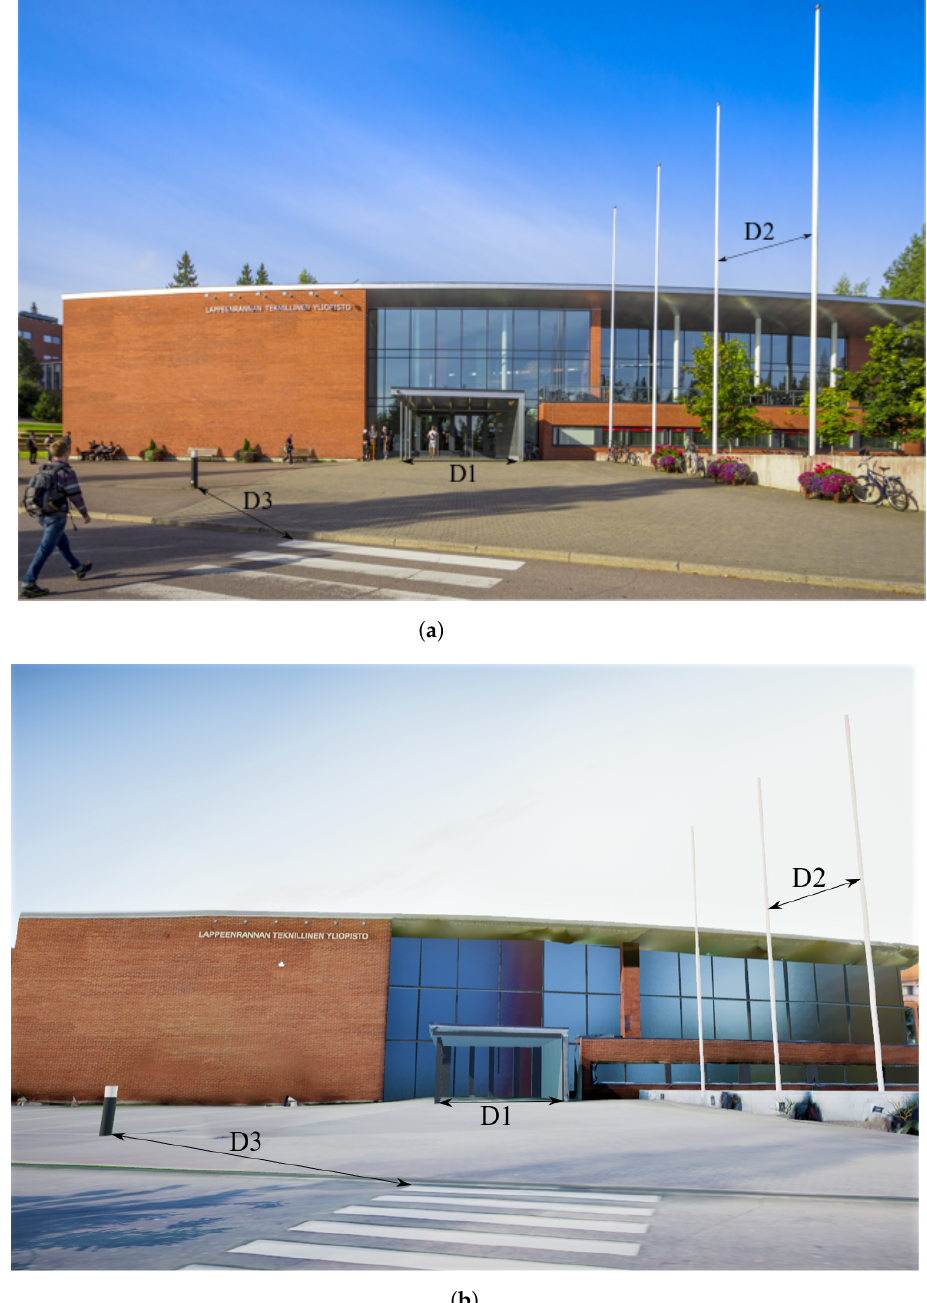
Figure 12. LUT University main entrance in the real world and in the graphical software using the photogrammetry-based approach: ( a ) Real world and ( b ) Unity